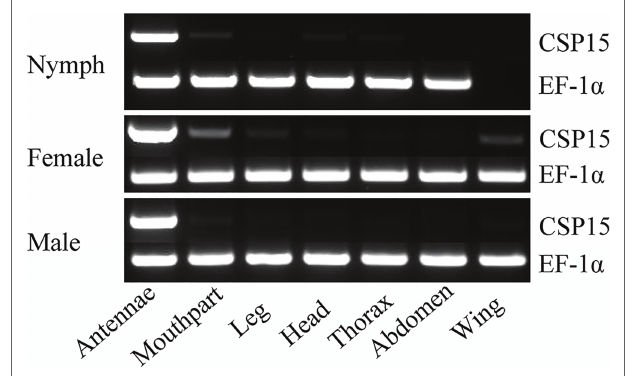
FIGURE 1 | Tissue-specific expression of HhalCSP15 in different stages (nymph and male and female adult) measured by reverse transcription PCR (RT-PCR). Elongation factor 1- α (EF-1 α ) was used as a control